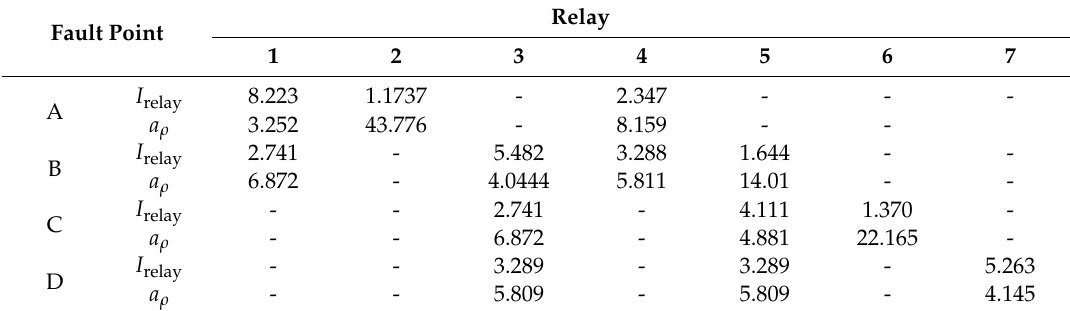
Table 11. a ρ constants and relay currents for Case